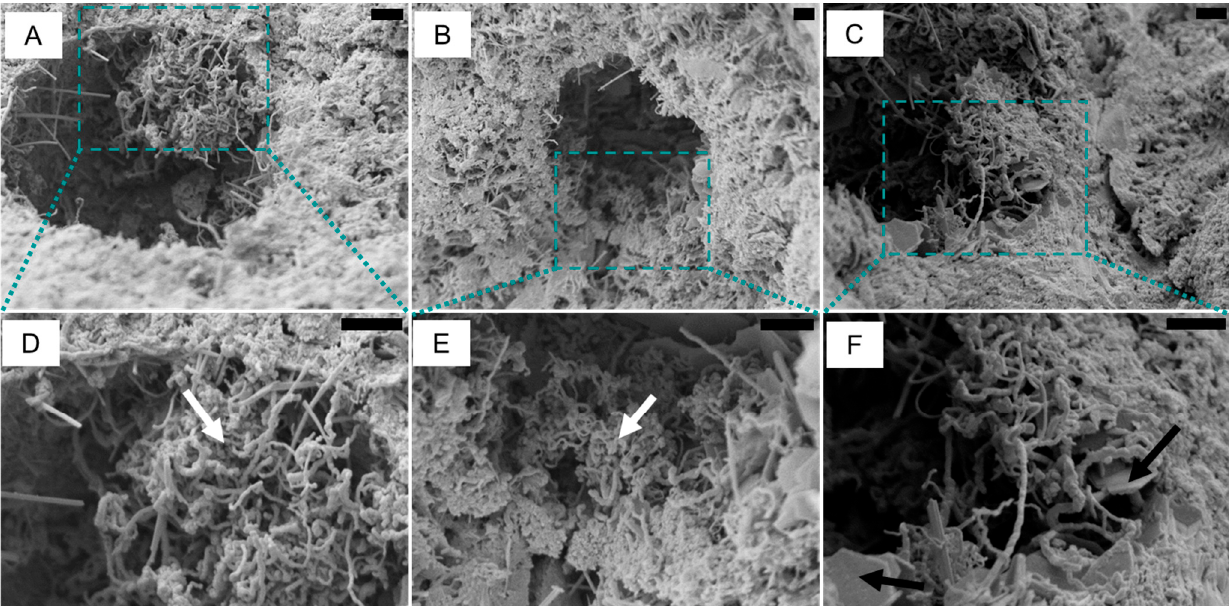
Figure 6. Scanning electron microscopy of carbon nanofibers supported in CaO, dispersed in mor- tar. Scale bar 2 μ m. ( A – C ) mortar surface containing the nest of CNF; ( D – F ) details of the CNF next, white arrows indicate CNF and black arrow indicate portlandite. white arrows indicate CNF and black arrow indicate